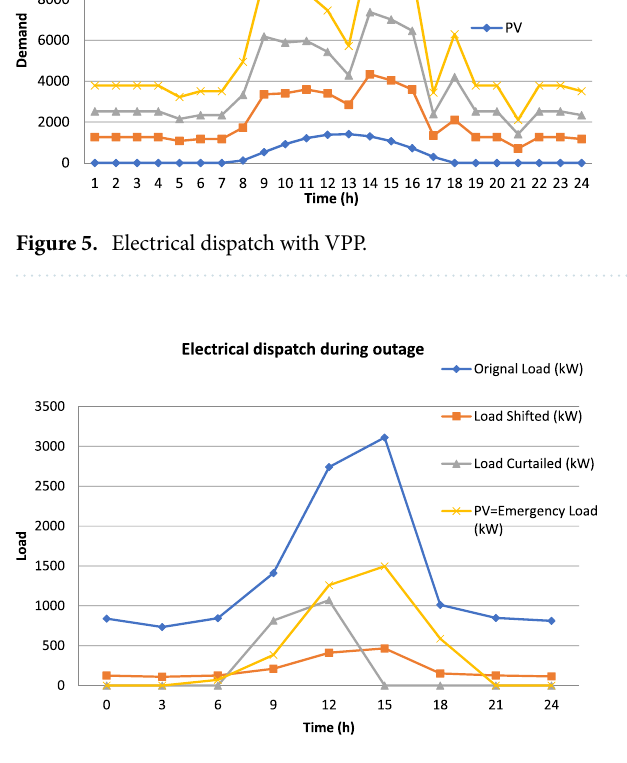
Figure 6. Electrical dispatch with VPP during an outage (Islanding